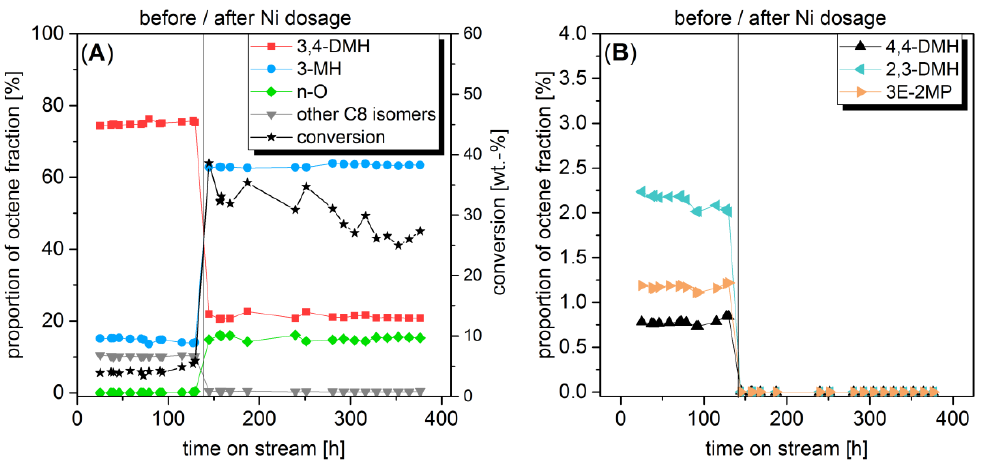
Figure 1. Distribution of octene skeletal isomers before and after in situ impregnation with Ni(cp) 2 at 140 h time on stream; ( A ) distribution of the main products and summarized side products for the respective conversion, ( B ) distribution of the side products stemming from the dimerization of n-butene. Not all C8 side products are equally suitable for assessing the remaining Brønsted acidity.